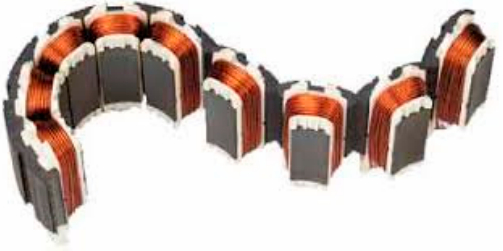
Figure 2. Modular structure of POKI-POKI TM machine [10].